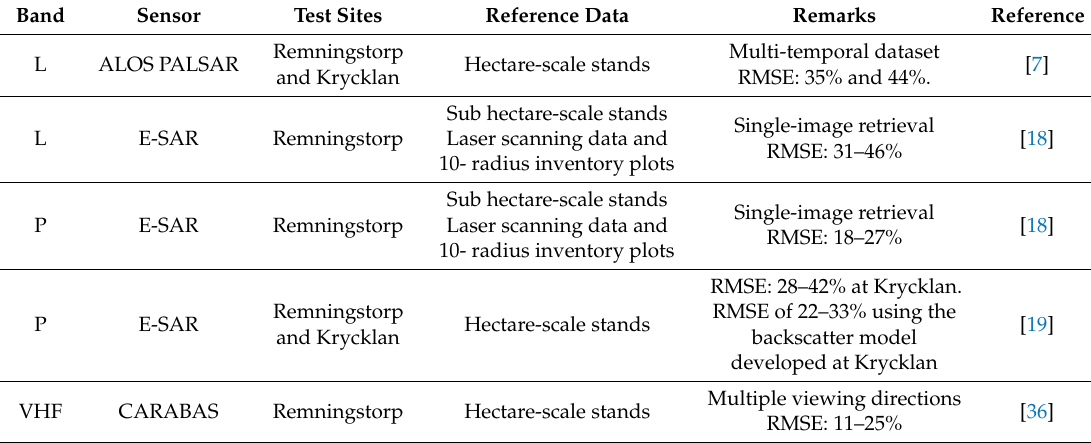
Table 6. Overview of previous studies dealing with retrieval of forest stem volume and above-ground biomass at the two test sites using SAR backscatter. Studies based on interferometric, polarimetric and polarimetric interferometric SAR observables are not considered because o ff